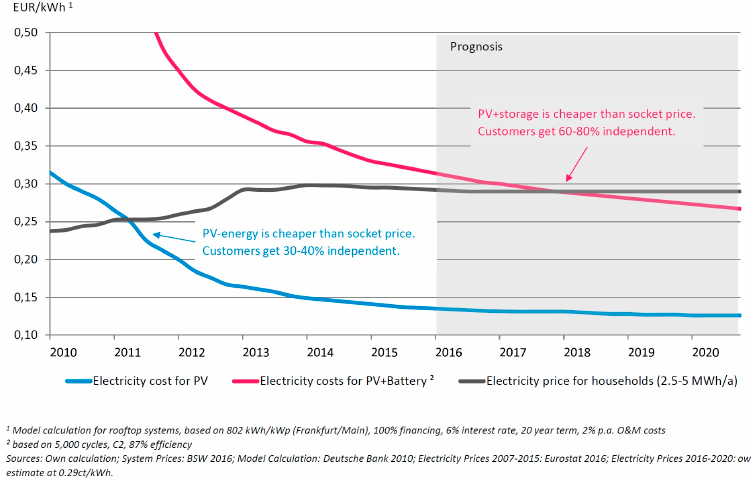
Figure 6. Comparison of photovoltaics (PV) grid parity and PV + battery parity in Germany [55].